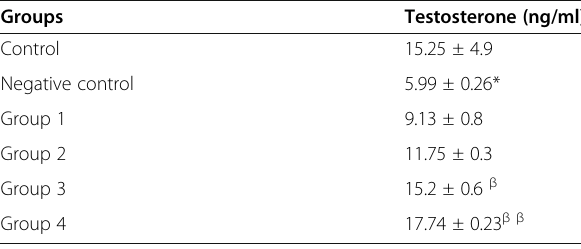
Table 4 Results showing the effect of aluminum chloride on testosterone hormone in adult male Wistar rats Groups